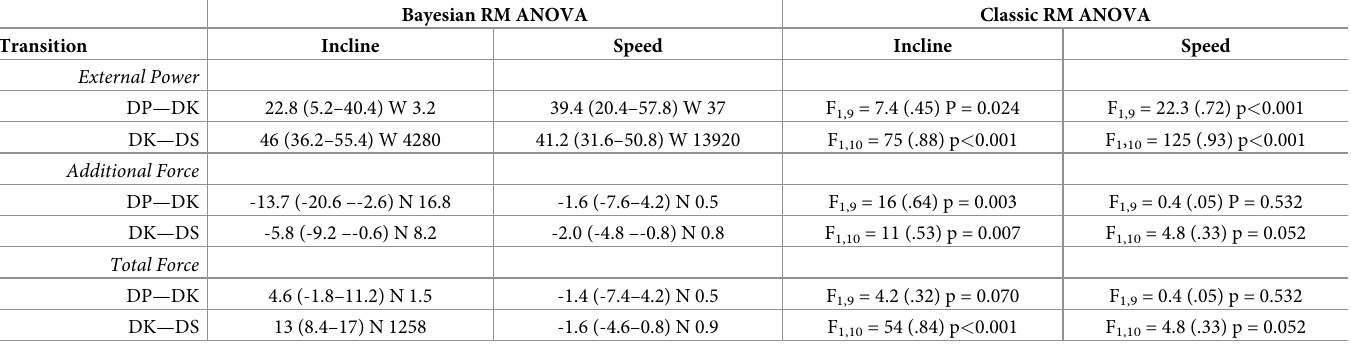
Table 1. Statistical outcome of 2x2 RM ANOVA: Bayesian estimated mean (95% CI) of the differences (8%—5% and 12–10 k h -1 ), BF inclusion , classical F-values ( η 2 ) and